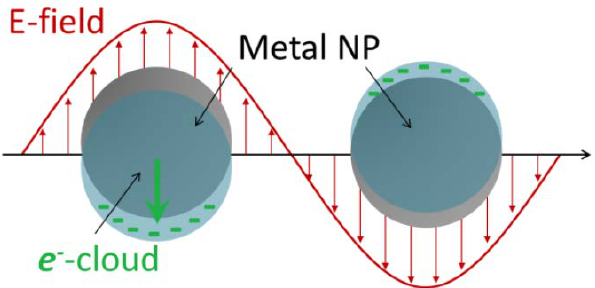
Figure 1. Schematic example of plasmon oscillation for a spherical gold NP showing the displacement of the conduction electron charged cloud relative to the core under the incoming oscillating electric field.